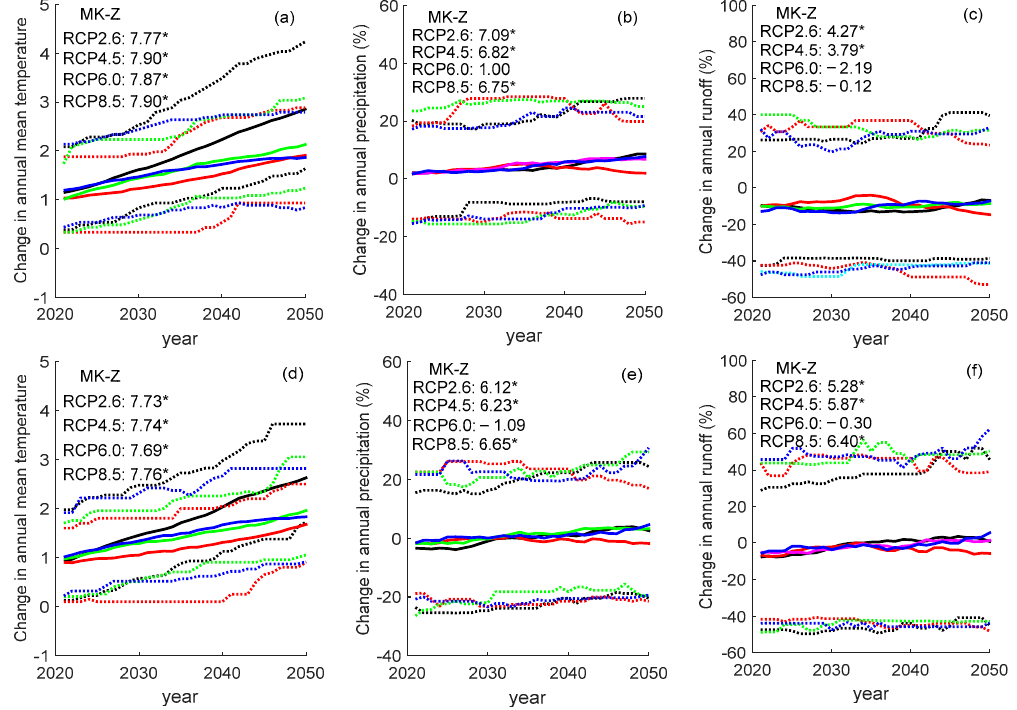
Figure 5. Changes in 20-year loop mean and 90% confidence bounds of the annual mean temperature, annual precipitation, and annual runoff relative to the baseline (1976–2005) in ( a – c ) the Yellow River Basin and ( d – f ) in the Xijiang River Basin. Blue, green, red, and black lines represent RCP2.6, RCP4.5, RCP6.0, and RCP8.5, respectively. Solid lines indicate RCP mean and dashed lines represent the 90% confidence bounds under each RCP scenario. The values of the Mann–Kendall statistic (MK-Z) were estimated based on RCP means during 2021–2050. * indicate trends significant at the 5% level.